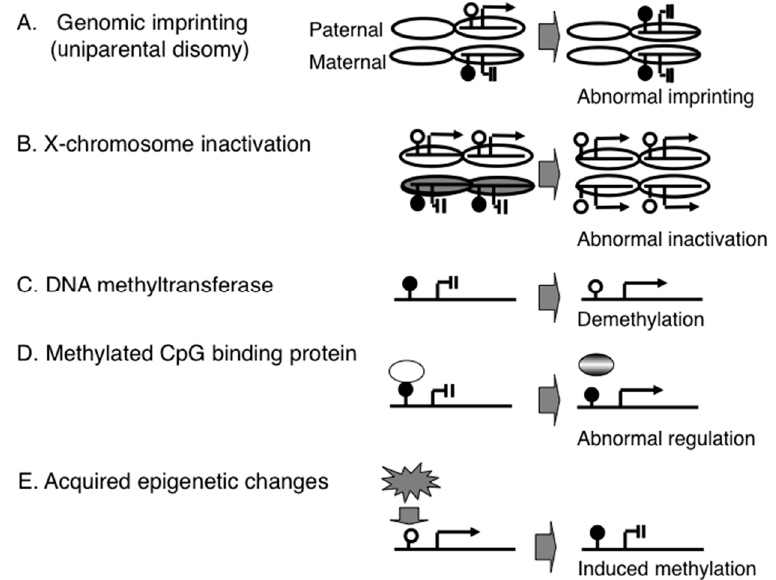
Figure 1. Epigenetic mechanisms associated with congenital and acquired disorders. ( A ) genomic imprinting and a congenital disorder (e.g., Prader-Willi syndrome); ( B ) X-chromosome inactivation and a congenital disorder (e.g., ring X Turner syndrome); ( C ) DNA methyltransferase and a congenital disorder (e.g., ICF syndrome); ( D ) methyl-CpG-binding protein and a congenital disorder (e.g., Rett syndrome); ( E ) epigenetic gene regulation system and an acquired disorder (e.g., type 2 diabetes).